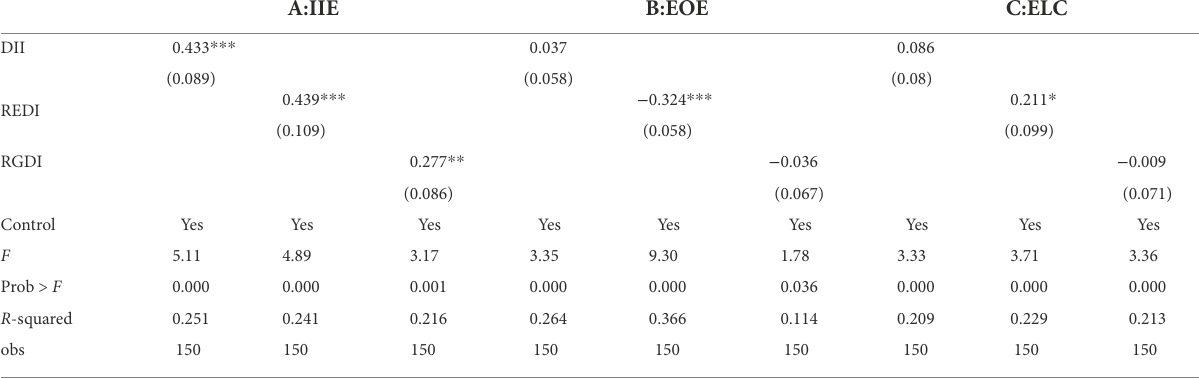
TABLE 4 Baseline regression results for the digital economy and